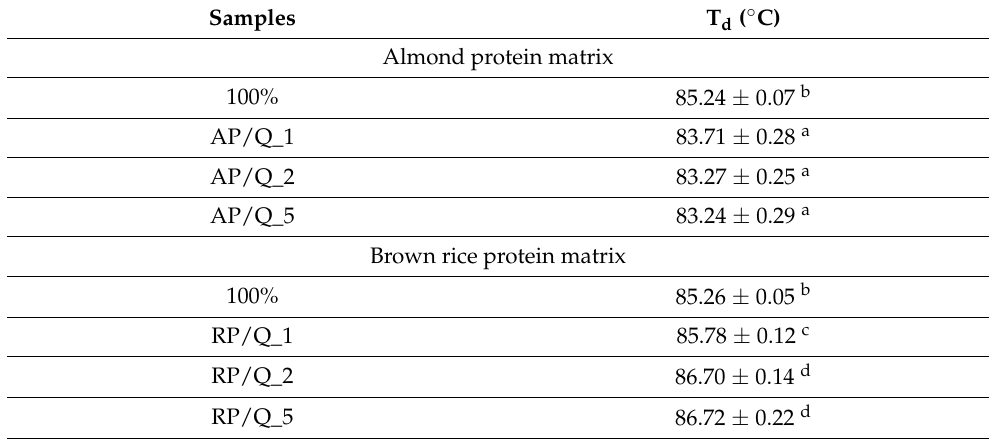
Table 2. Temperatures of denaturation (T d ) of protein matrices and protein/quercetin microparticles.